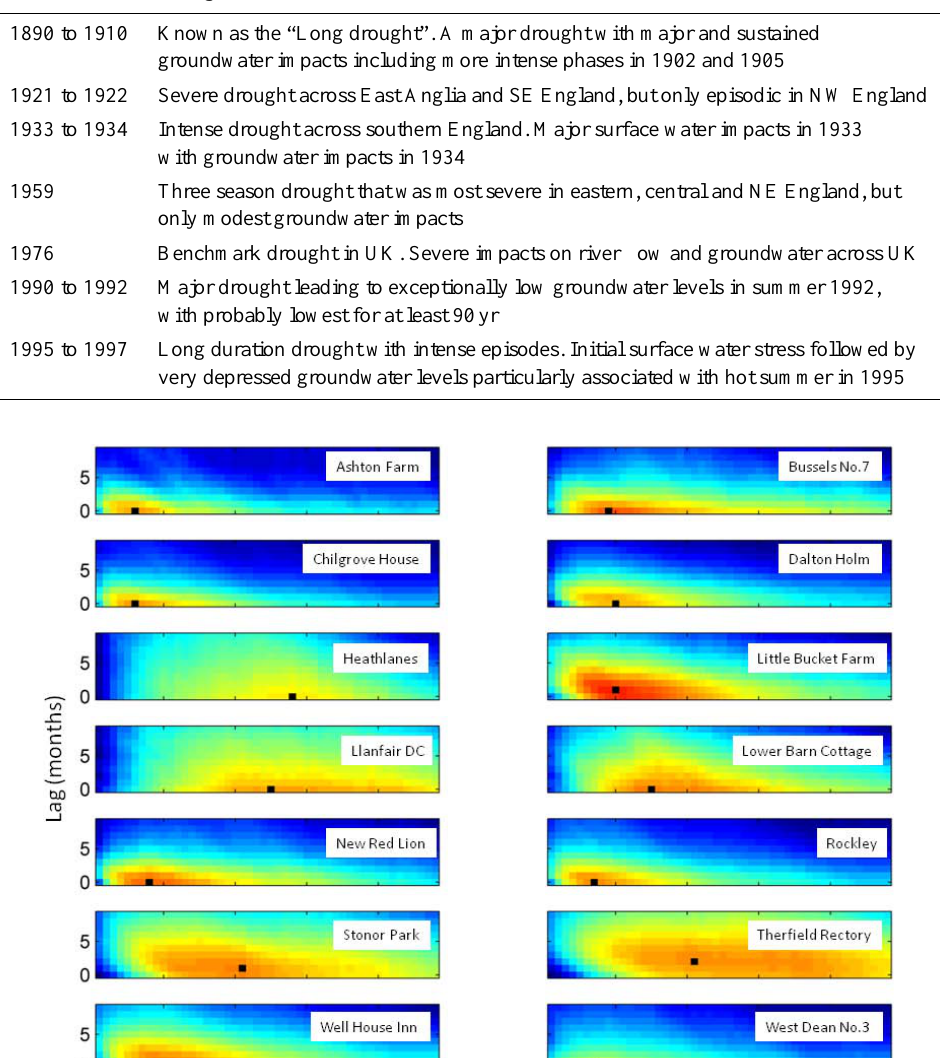
Table 3. Summary of the major droughts in England from 1900 to 2006 (after Marsh et al., 2007 and National River Flow Archive, 2013). Period